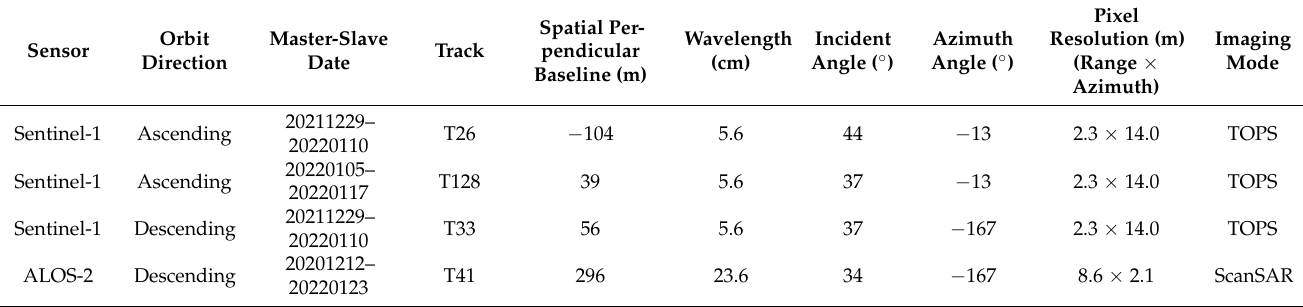
Table 1. Basic information of the SAR data used in this